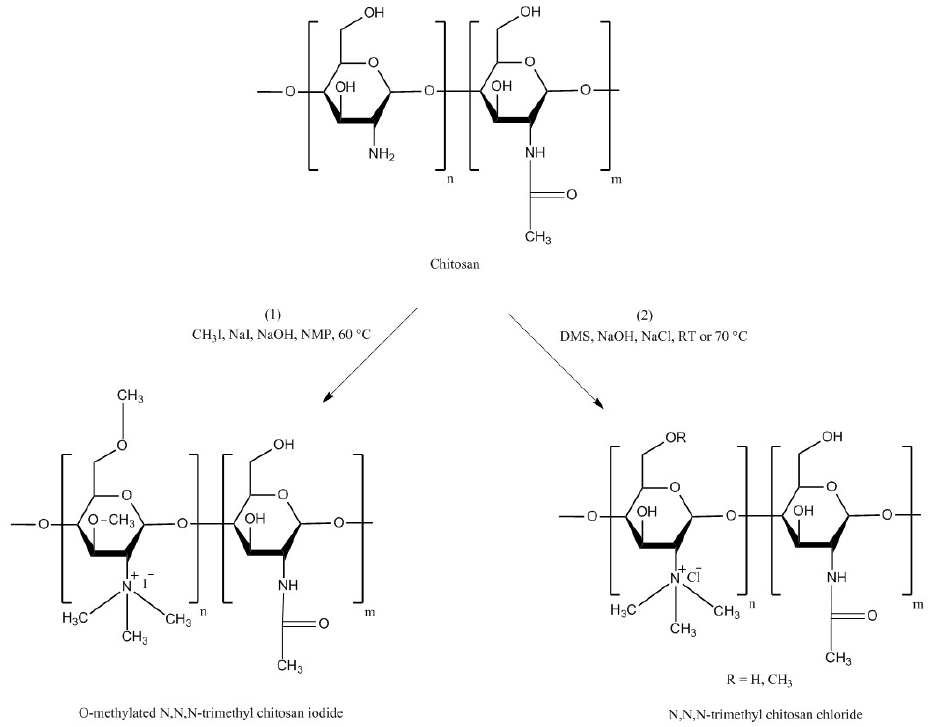
Figure 5. Synthetic pathway for preparation of TMC using direct trimethylation approach according to (1) Sieval et al. [52], NMP = N -methyl-2-pyrrolidinone and (2) de Britto and Assis [53], DMS = dimethyl sulfate.